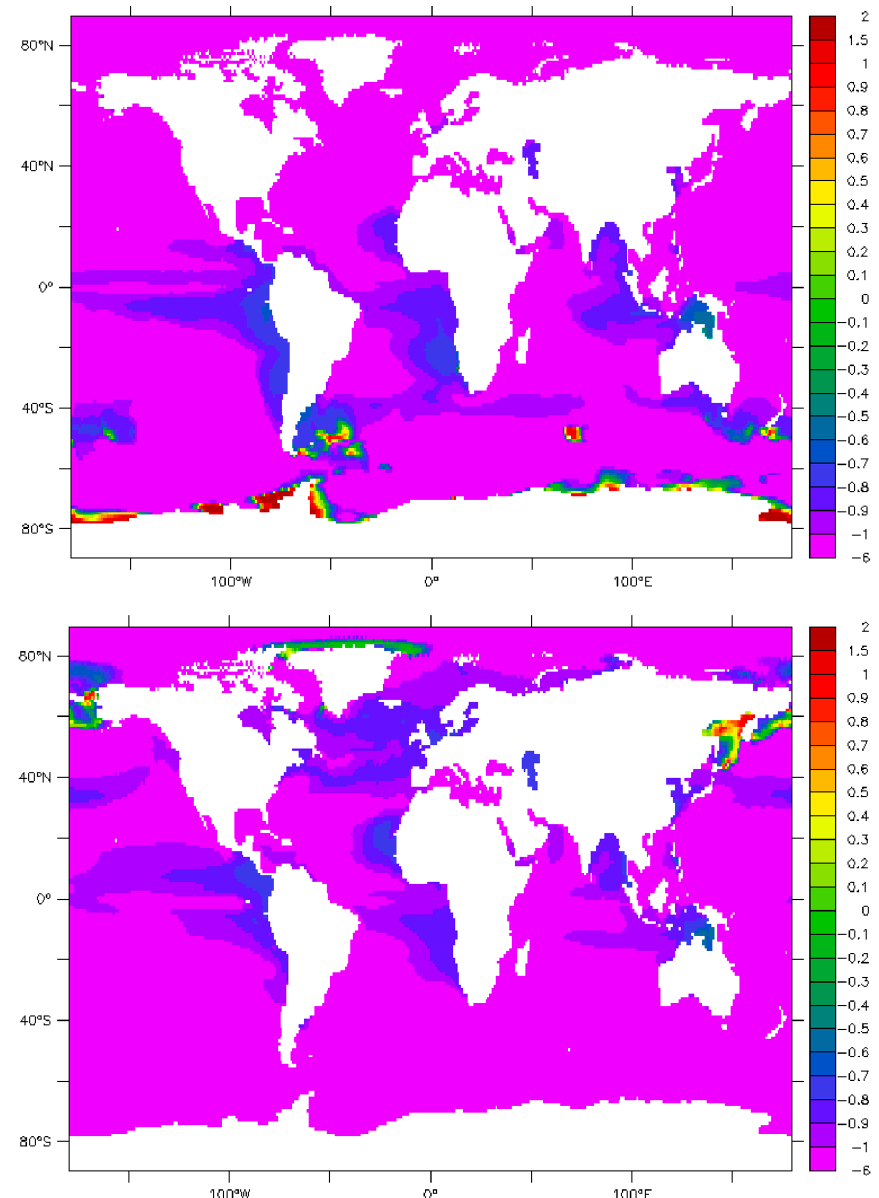
Figure 5. Log surface pressure maps ( Δ tension) with protein levels decremented 10×, while lipids are returned to baseline. The color bar has been set so that a reference range of 0.3–3 mN/m is central ( − 0.5 to 0.5 in log units). February and August monthly averages are shown for a typical year near the turn of the millennium.